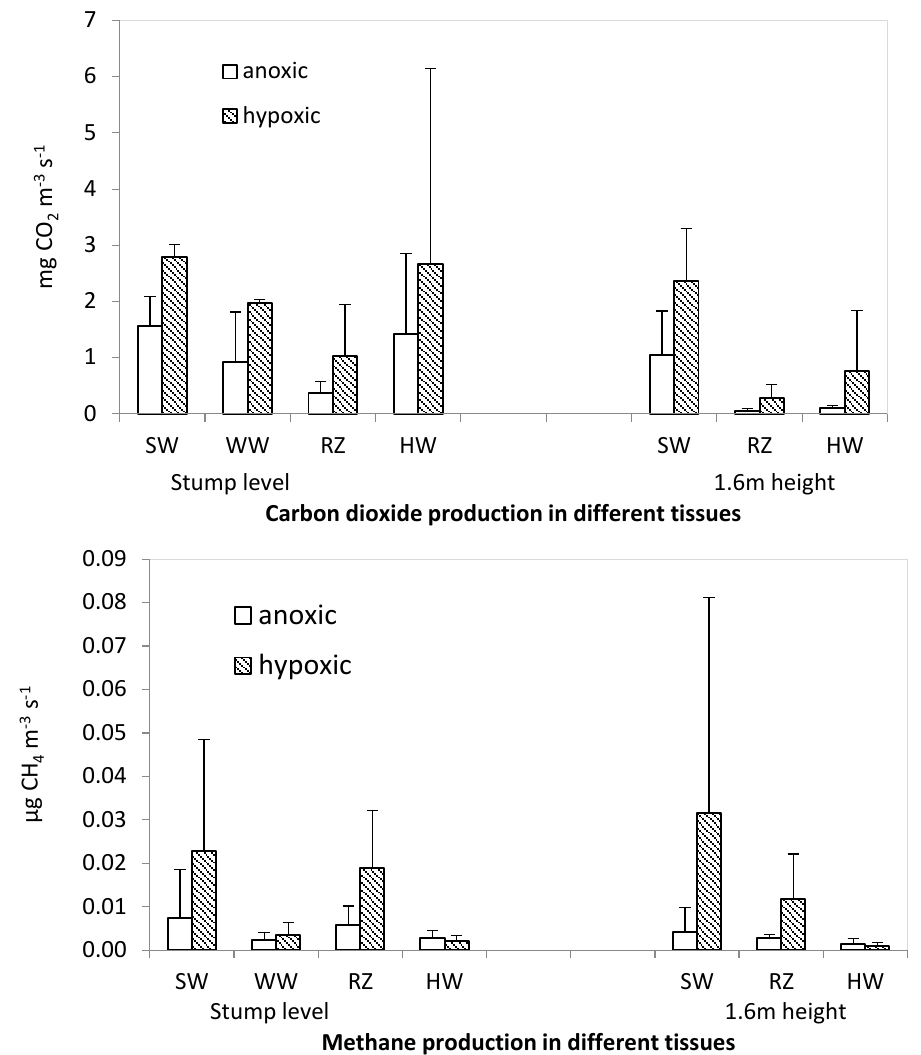
Figure 5. Average production rates of carbon dioxide and methane in the tissue-type samples dissected from two heights from tree #6, and incubated for 23 days at anoxic and hypoxic laboratory conditions. SW—healthy sapwood (stump level, n = 3; breast height, n = 6); WW—wetwood ( n = 2); RZ—uncolonized reaction zone ( n = 3); HW—colonized heartwood (stump level, n = 5; breast height, n = 3). Error bars represent ±one standard